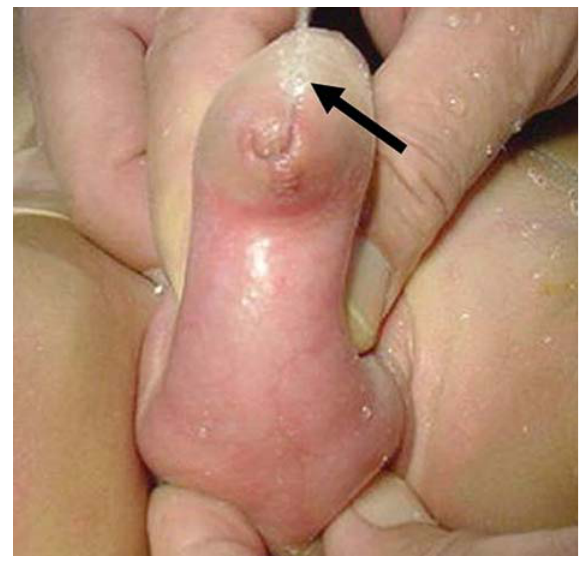
Figure 2 – Typical penoscrotal ballooning of the congenital megaprepuce.